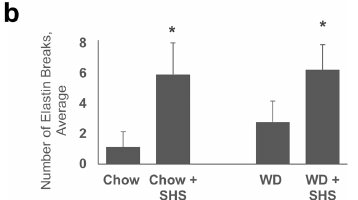
Figure 1. Hart’s Elastin stained lung tissue sections from ApoE − / − mice. ApoE − / − mice were fed rodent chow without (Chow) or with second hand smoke exposure (Chow + SHS). Other groups were fed Western Diet without (WD) or with smoke exposure (WD + SHS). ( a ) Representative images are shown. Black arrows point out strand breaks in alveolar walls, 20x objective used. Destruction of alveolar walls was assessed by counting numbers of breaks in elastin fibers ( b ). Groups exposed to SHS scored significantly higher, the Kruskal-Wallis ANOVA on ranks was used to assess statistical significance between groups ( p < 0.001) followed by post hoc testing with Dunn’s multiple comparison test for groups of interest ( p < 0.05), four to six mice per group were analyzed, * Significant difference detected. To study the differences in airspace enlargement in lungs of ApoE − / − mice with or without cigarette smoke exposure we calculated the mean linear intercept length (MLI) [21] using Hematoxylin and Eosin stained lung tissue sections. As shown in Figure 2, the MLI was significantly higher in smoke exposed mice fed regular diet (Figure 2B) as well as in mice fed WD and exposed to smoke relative to non-smoking groups (Figure 2B).